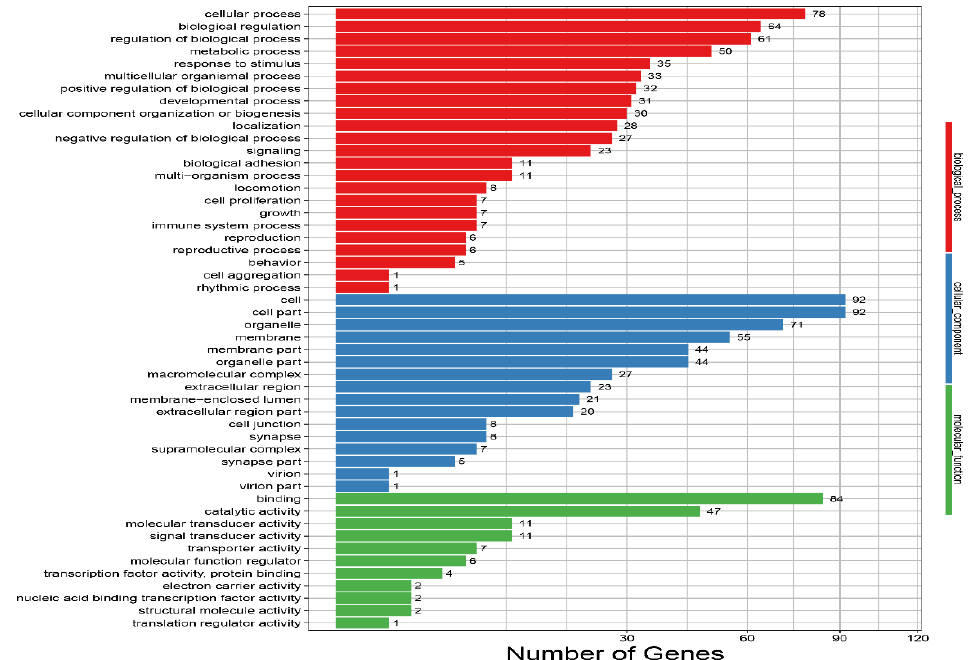
Figure 6. Enriched GO terms for the BG and the PLG. The vertical axis indicates GO terms, and the horizontal axis represents the number of DEGs. The numbers of enriched genes in each GO term are shown in the biological process (red color), cellular component (blue color), and molecular function (green color) areas. BG, barren environment group; PLG, environment enriched with perches and a litter materials group.